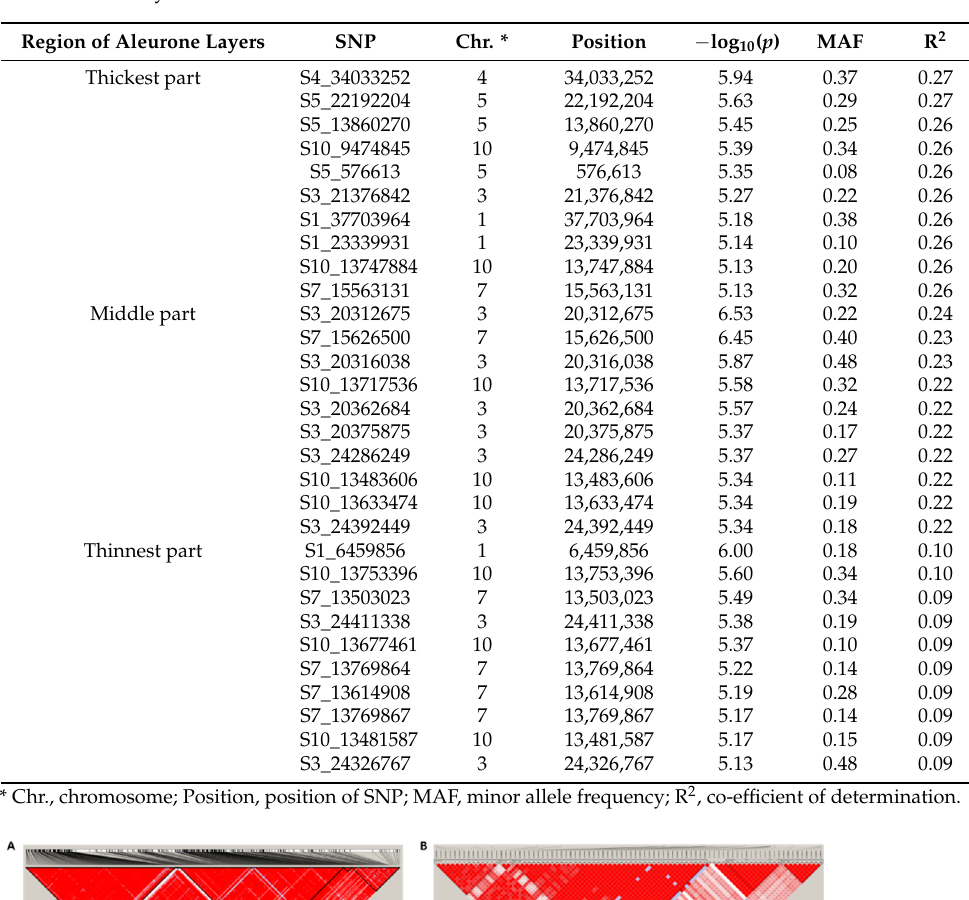
Table 2. Single nucleotide polymorphism (SNPs) locations associated with the thickness of seed coat and aleurone layers in the 294 rice core collection.